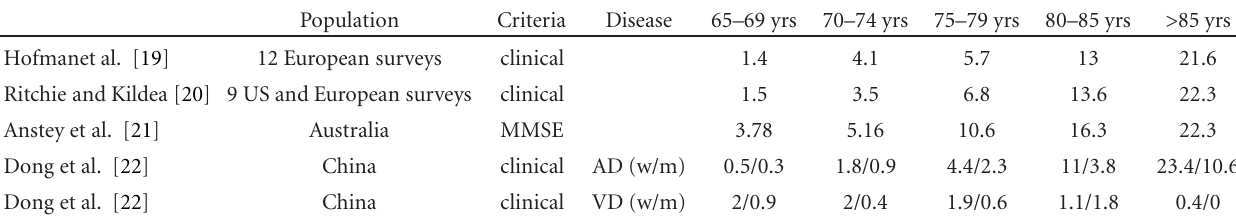
Table 1: Age-dependent prevalence of dementia (%) in selected populations.